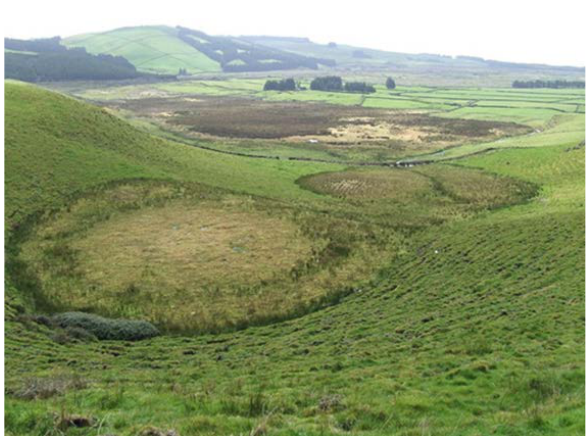
Figure 2. View across the Criação de Filipe peatland